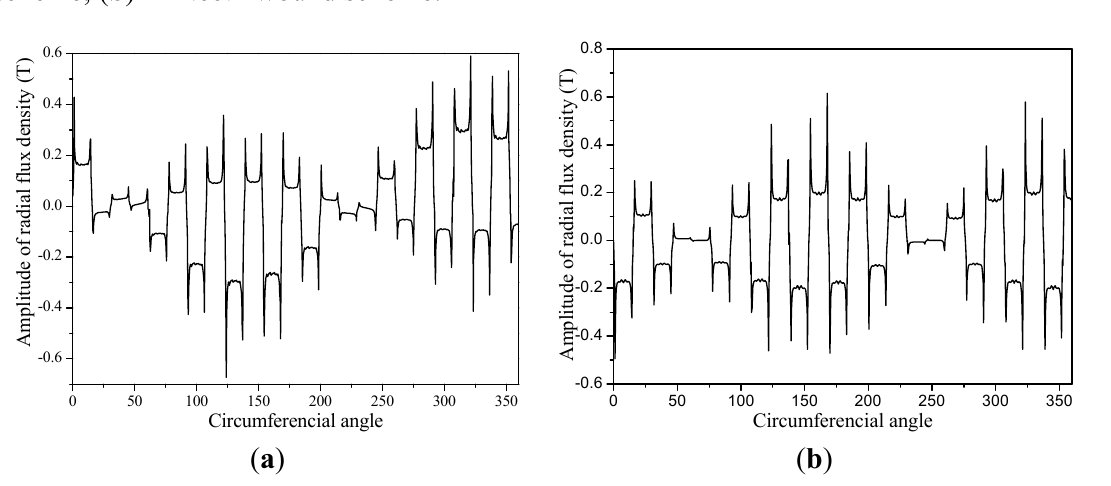
Figure 5. Air-gap flux density of 24-slot/22-pole PMSM: ( a ) Alternate teeth wound scheme; ( b ) All teeth wound scheme.